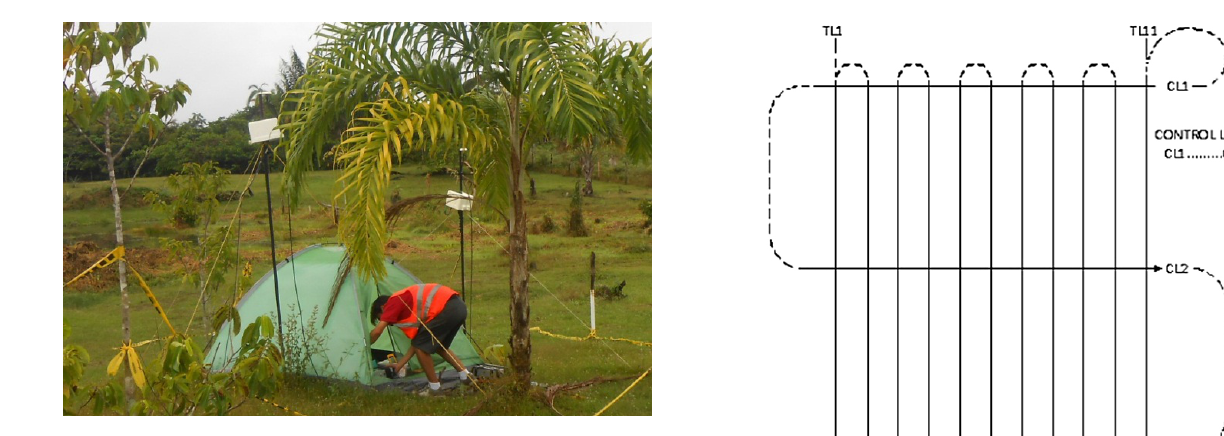
Figure 15. Example of a day monitoring BaseMag station, which measures the magnetic field in parallel to an airborne geophysi- cal acquisition site (source: S. Guimarães, author private collection, January 2015).